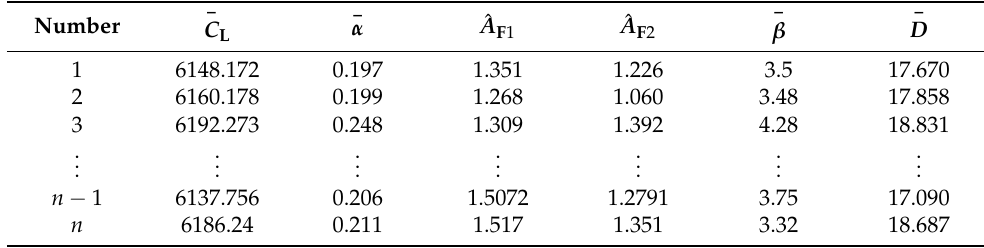
Table 1. Partial original data of TC25 materials.